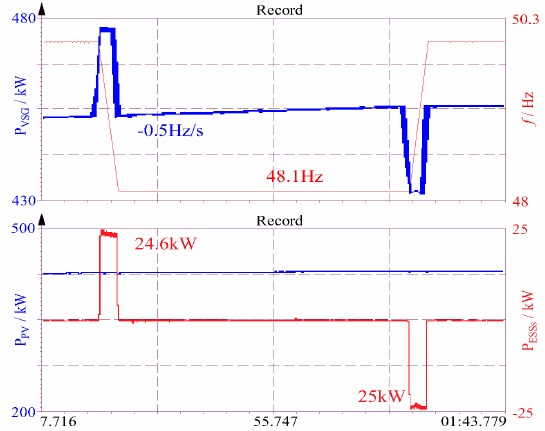
Figure 2. PV-energy storage systems (ESSs)-VSG output wave.